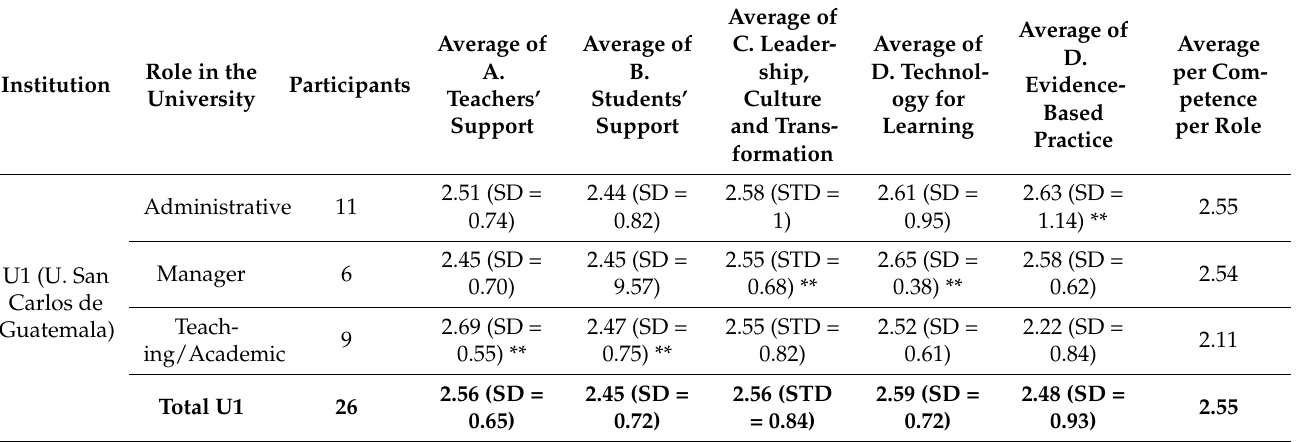
Table A3. Data analysis of [Competencies Questionnaire]. We calculated the average value given for each competence dimension for the different stakeholders and per each institution. With **, we indicate the highest values for each competence per stakeholder in each institution. The values given by the participants are between 1 (minimum) and 4